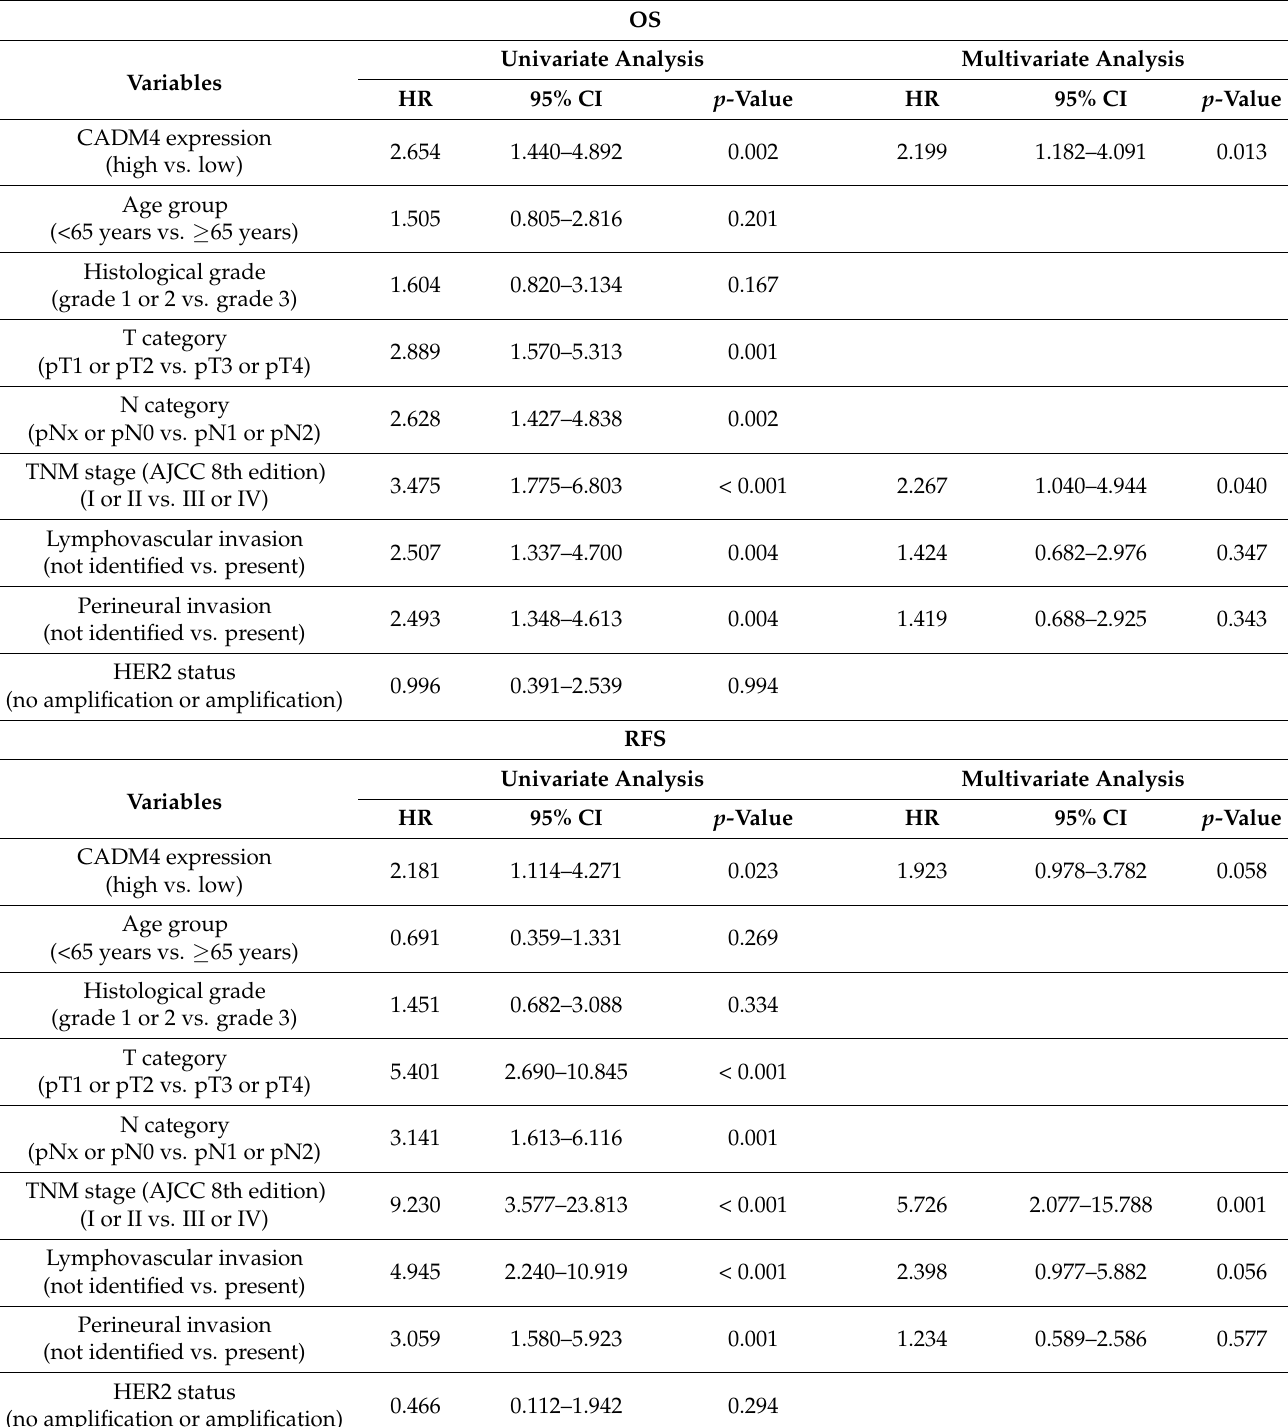
Table 3. Univariate and multivariate Cox regression analyses in patients with gallbladder cancer (n =